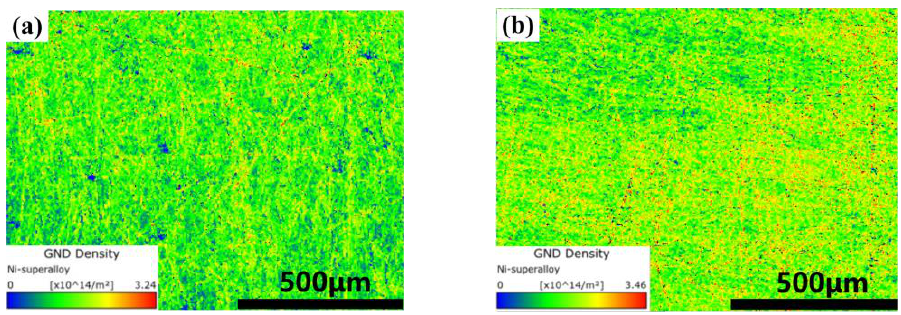
Figure 10. Geometrically necessary dislocation (GND) density mapping: ( a ) VED = 96 J·mm −3 ; ( b ) VED = 119 J·mm −3 .